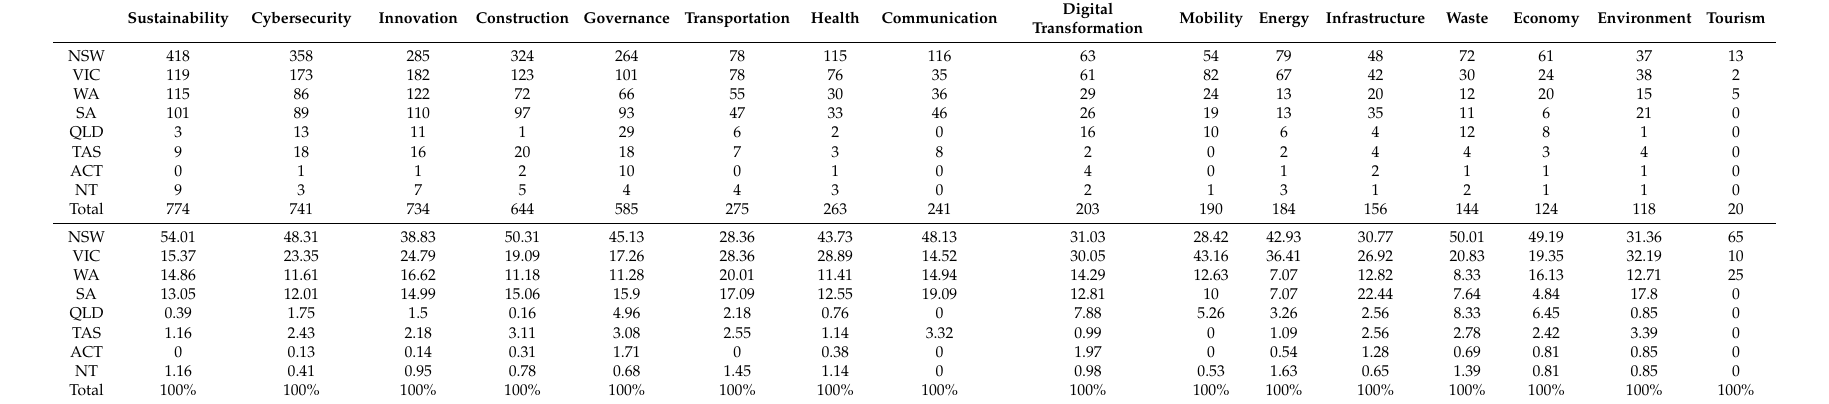
Table 5. Distribution of tweets by urban planning and development concepts per state / territory.